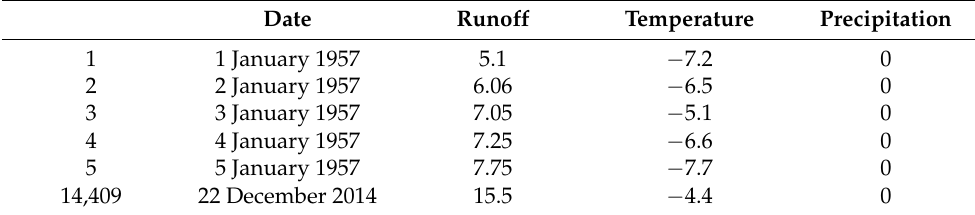
Table 1. Data samples in the study area.